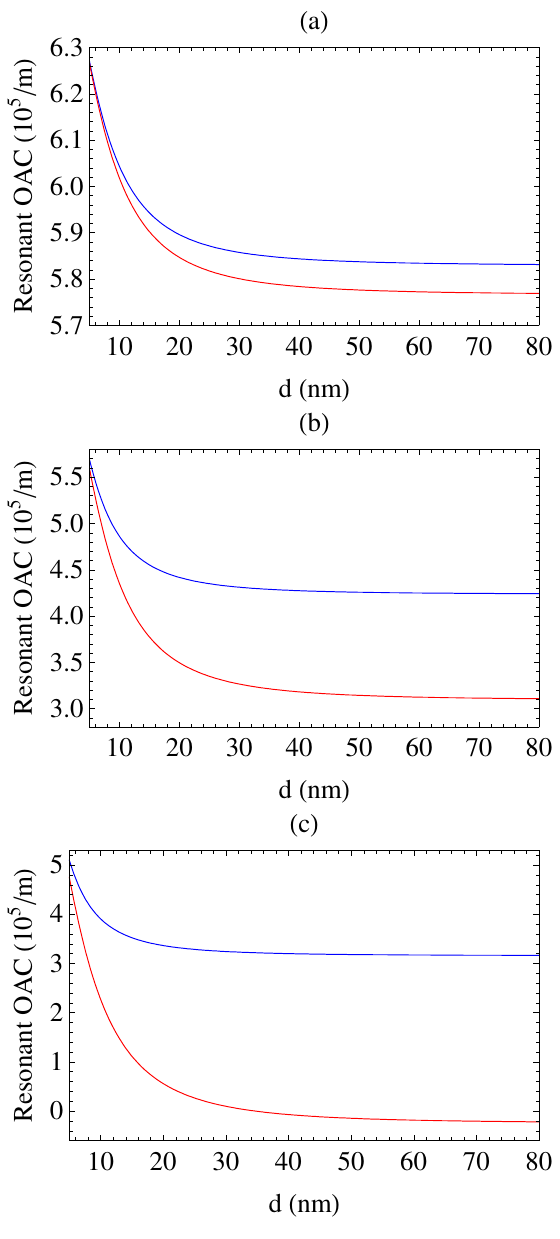
Figure 4. (Color online) The OAC on resonance, ω = ω 21 , as a function of distance d for the electric field polarized along the z axis. The light intensities are ( a ) I = 10 9 W/m 2 , ( b ) I = 5 × 10 9 W/m 2 , and ( c ) I = 10 10 W/m 2 . With blue curve, we plot α tot ( ω 21 , I , d ) and with red curve, we plot α ( ω 21 , I , d )